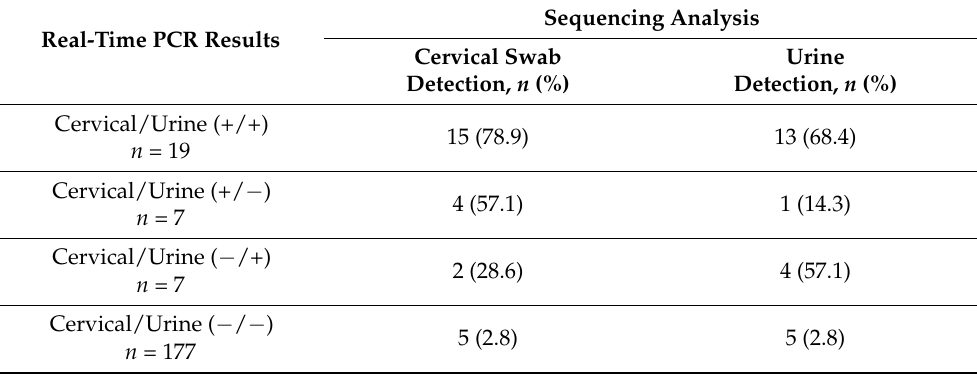
Table 3. Analysis of HPV DNA sequencing detection according to HPV real-time PCR